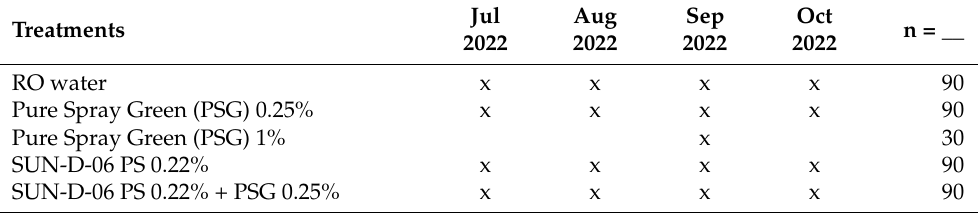
Table 3. Treatments evaluated for efficacy against western flower thrips (WFT) in greenhouse assays conducted during 2022. ‘x’ indicates the specific treatment was evaluated during the month/year the column represents. ‘n’ indicates the total number of replicates for each treatment. Treatments